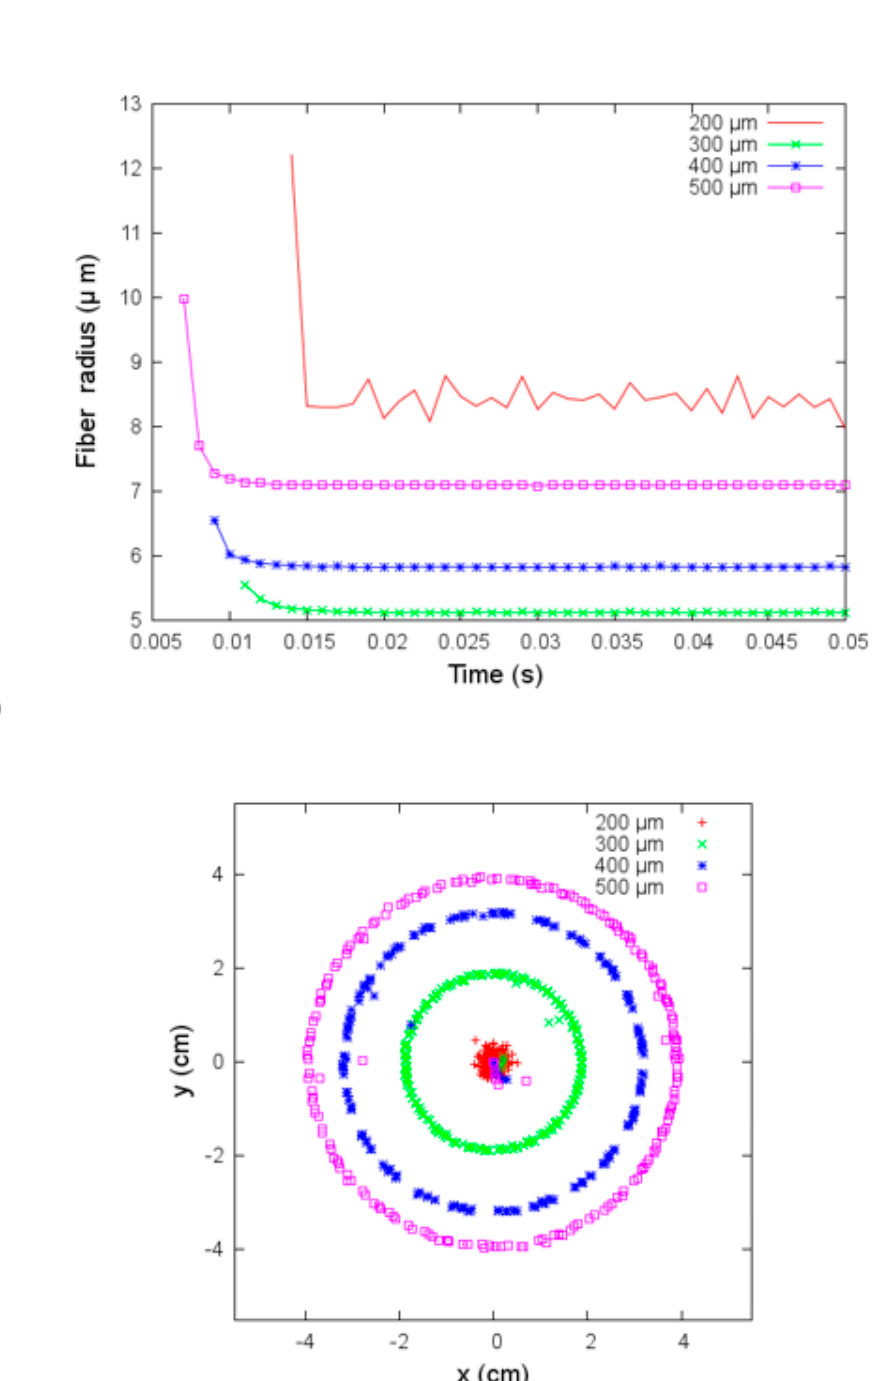
Figure 9. ( a ) Fiber radius versus time and ( b ) coordinates on the x-y plane where the jet hits the collector for different sizes of nozzle radius with flow velocity equal to zero under parameters given in Table 3.